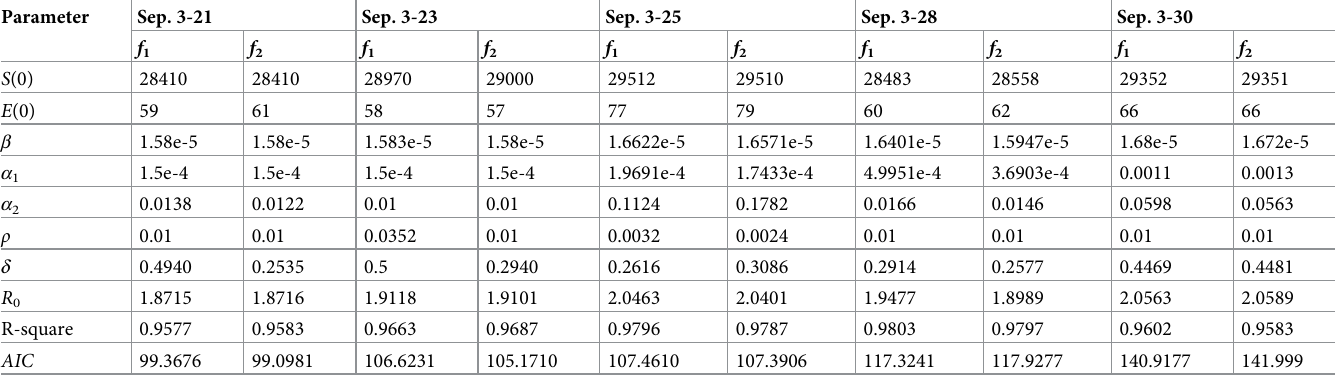
Table 2. Parameter estimates based on data from the 8th hospital of Xi’an after 3rd September. Parameter